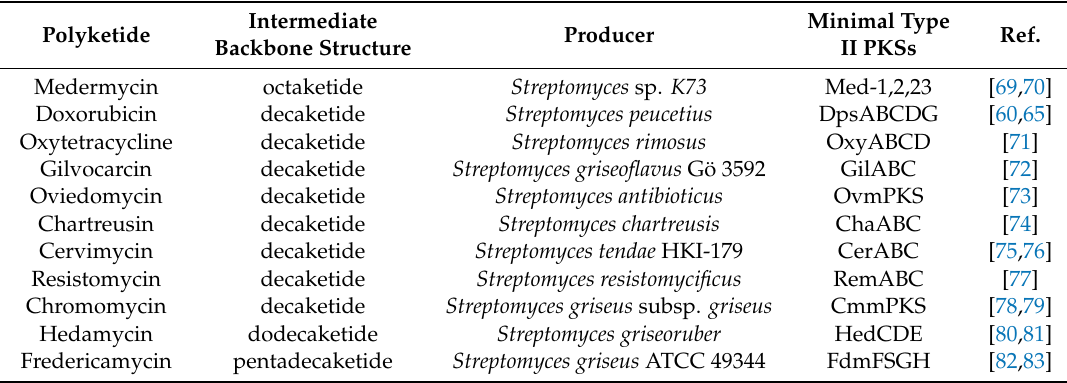
Figure 6. Biosynthesis of doxorubicin. Adapted with permission of The Royal Society of Chemistry 2009, from Chan, Y.A.; Podevels, A.M.; Kevany, B.M.; Thomas, M.G. Biosynthesis of polyketide synthase extender units. Nat. Prod. Rep. 2009 , 26 , 90–114 [60]; permission conveyed through Copyright Clearance Center, Inc. Table 2. Some polyketides produced by Streptomyces and their minimal type II